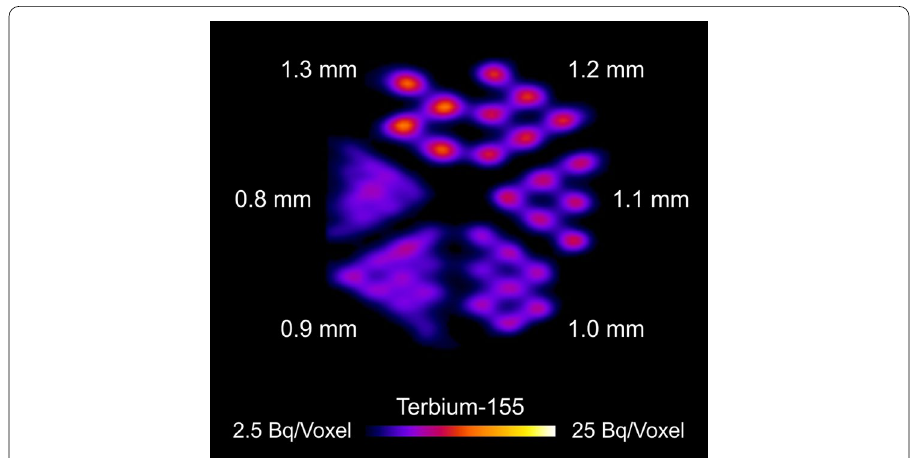
Fig. 6 Fifteen-minute SPECT scan of sagittal sections of Derenzo phantom filled with terbium-155 (10 MBq). No filter was applied.